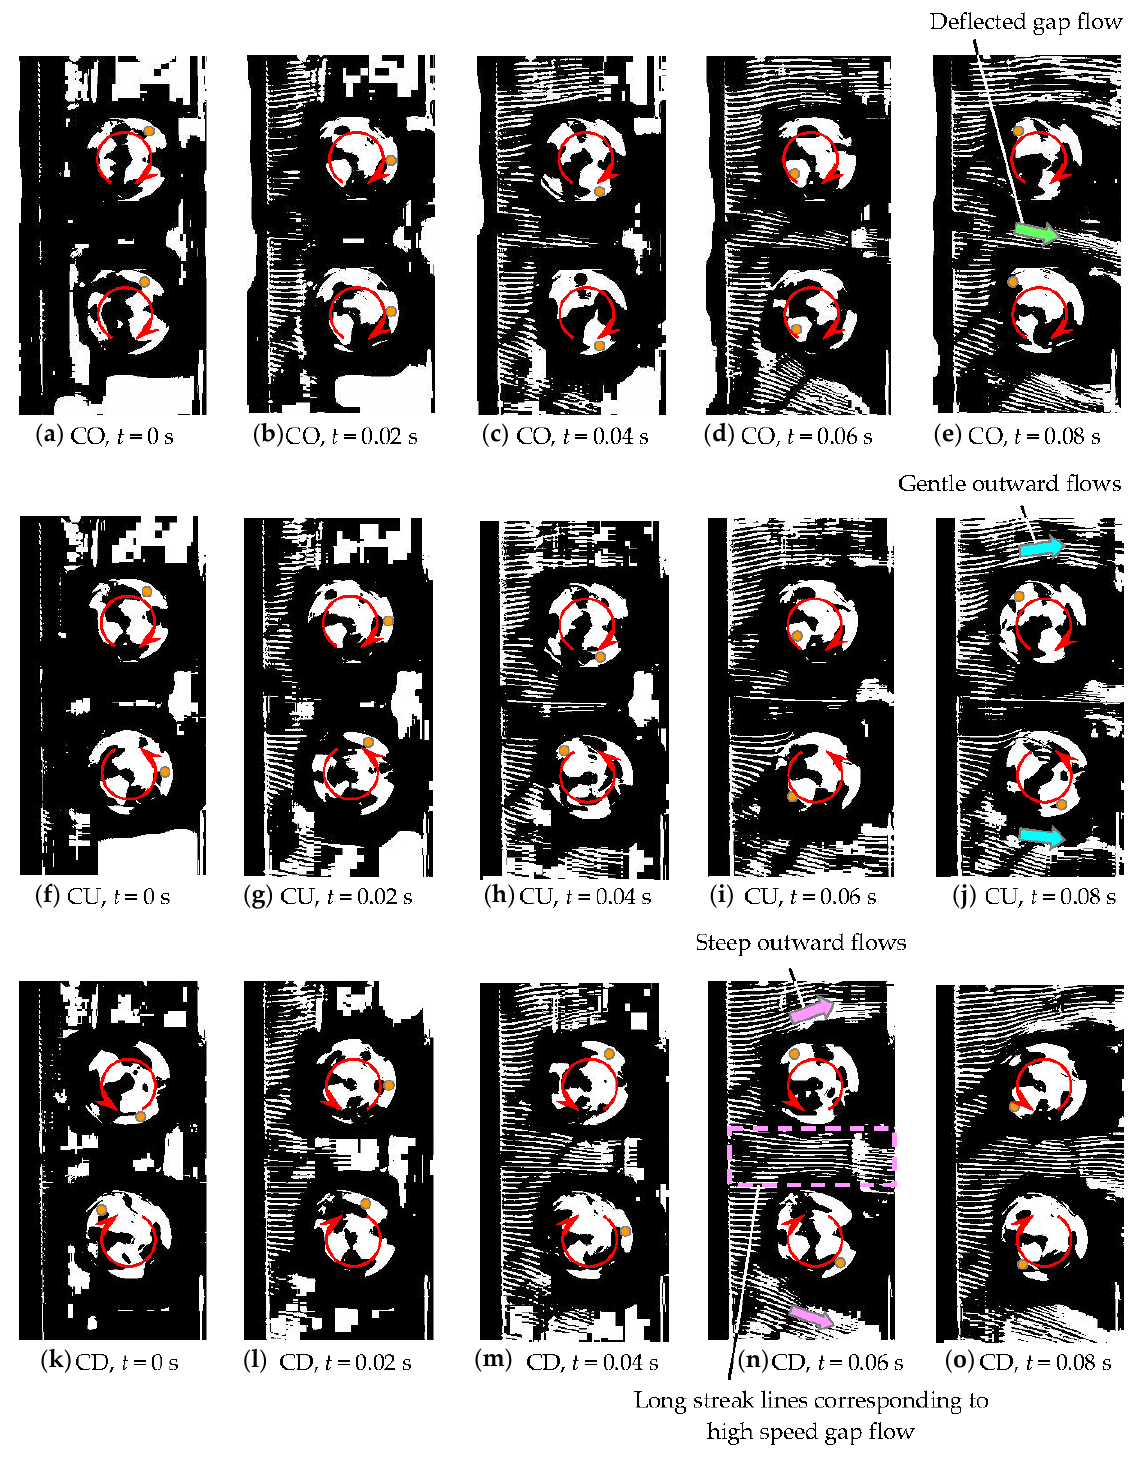
Figure 15. Time series ( t = 0–0.08 s) of binarized images of smoke flow past two turbines arranged side-by-side at g / D = 1.0, rotating at 600 rpm under V = 2 m/s: ( a – e ) CO; ( f – j ) CU; ( k – o ) CD. A temporal interval of 0.02 s corresponds to 1/5 rotation (72°).